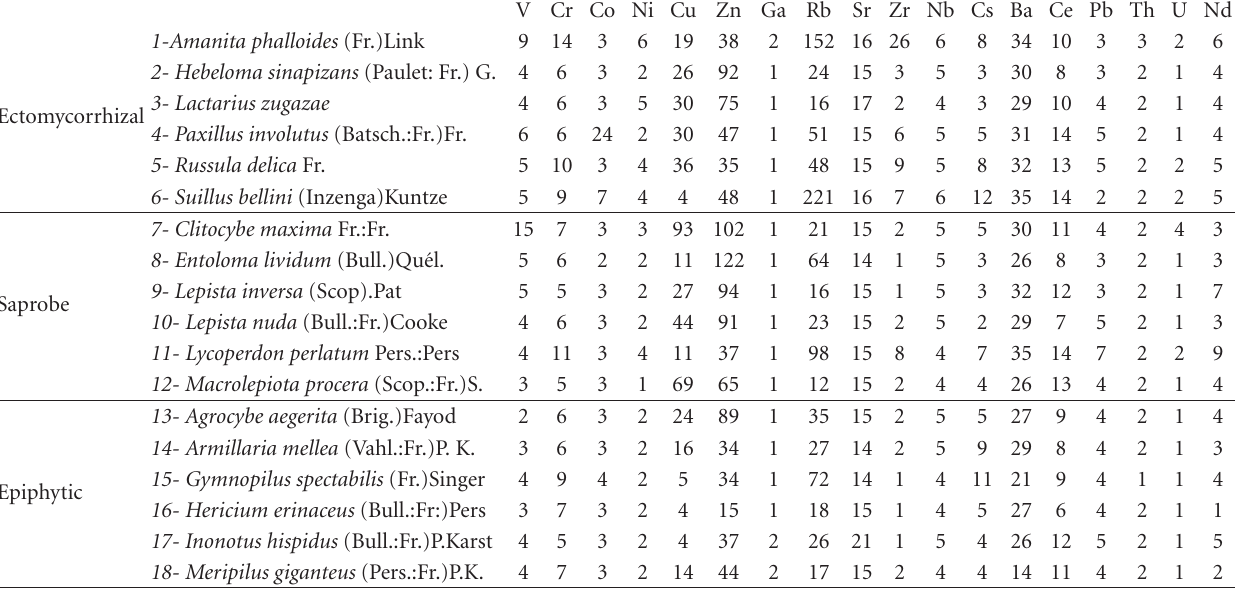
Table 1: Content ( µ g · g − 1 DM) of trace elements in fungi sporocarps for the 18 species studied. The species are sorted by their lifestyle (Ectomycorrhizae, saprobes, and epiphytic).